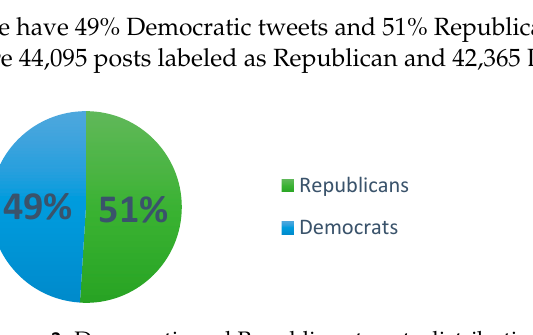
Figure 3. Democratic and Republican tweets distribution in the data set.